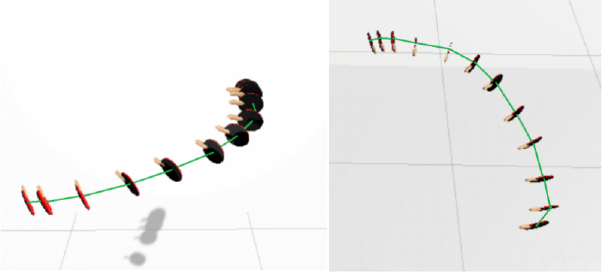
Figure 17. ( left ) fast swing trajectory simulation; ( right ) slow swing trajectory